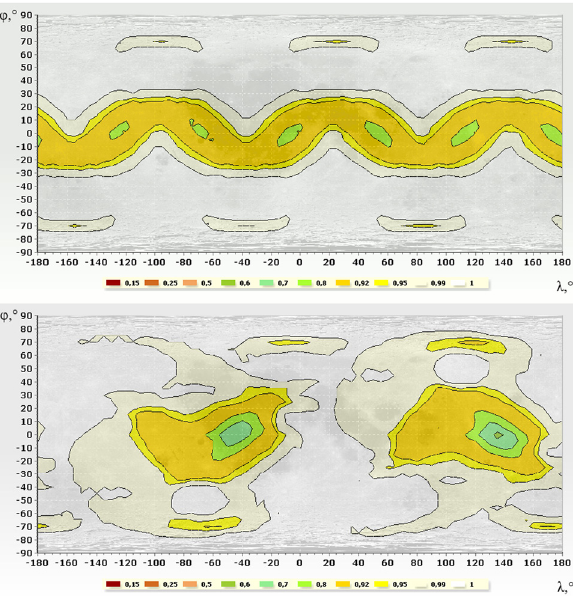
Figure 4: Dual - satellite coverage for nominal and degraded over 10 years LNSS constellation.